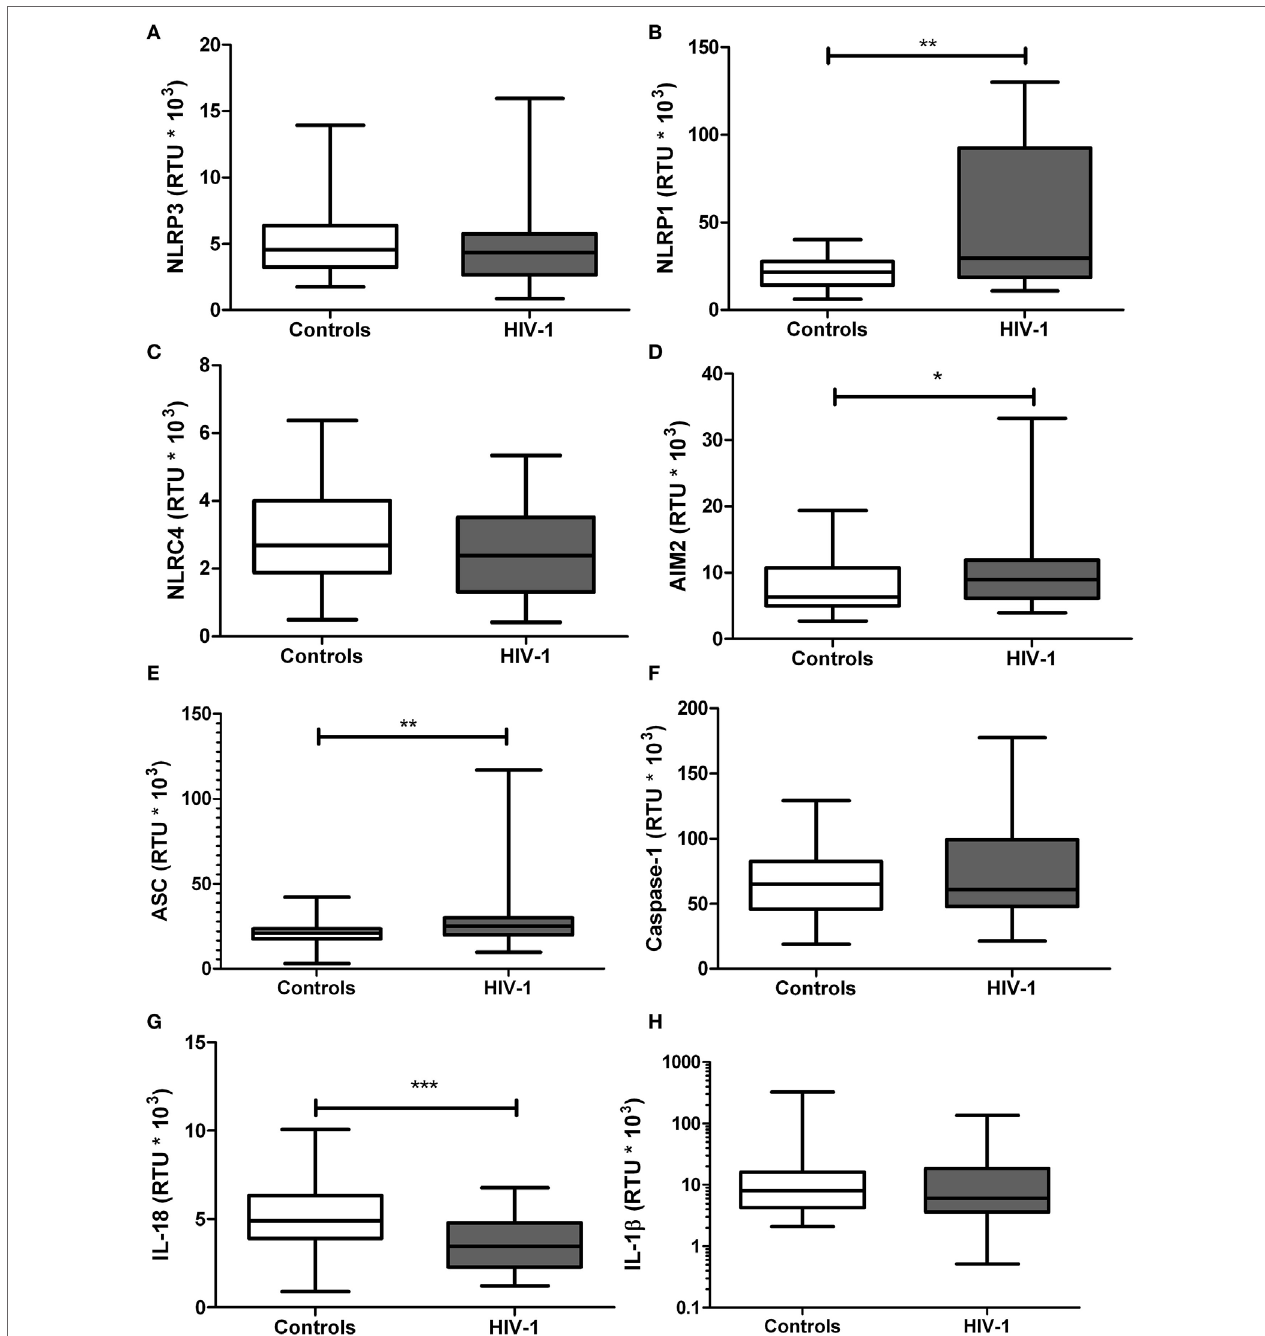
FigUre 2 | mRNA expression of inflammasome-related genes in human immunodeficiency virus type 1 (HIV-1)-infected individuals and healthy controls. RNA samples obtained from HIV-1-infected individuals and controls were quantified by real-time PCR: (a) NLRP3, (b) NLRP1, (c) NLRC4, (D) AIM2, (e) ASC, (F) caspase-1, (g) IL-18, and (h) IL-1 β . β -Actin was used as the constitutive gene to normalize the RNA content. The statistical comparison was made using the Mann–Whitney U test with a 95% confidence level. Significant differences are represented in the upper part of this figure (* p < 0.05; ** p < 0, 01; and *** p <